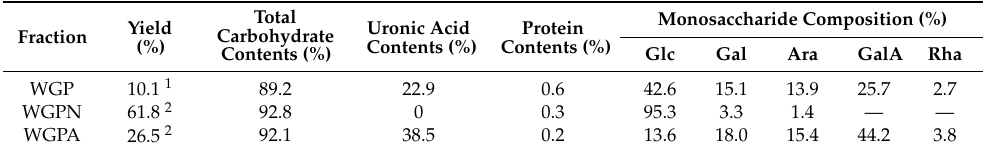
Table 2. Yield and physiochemical features of collected